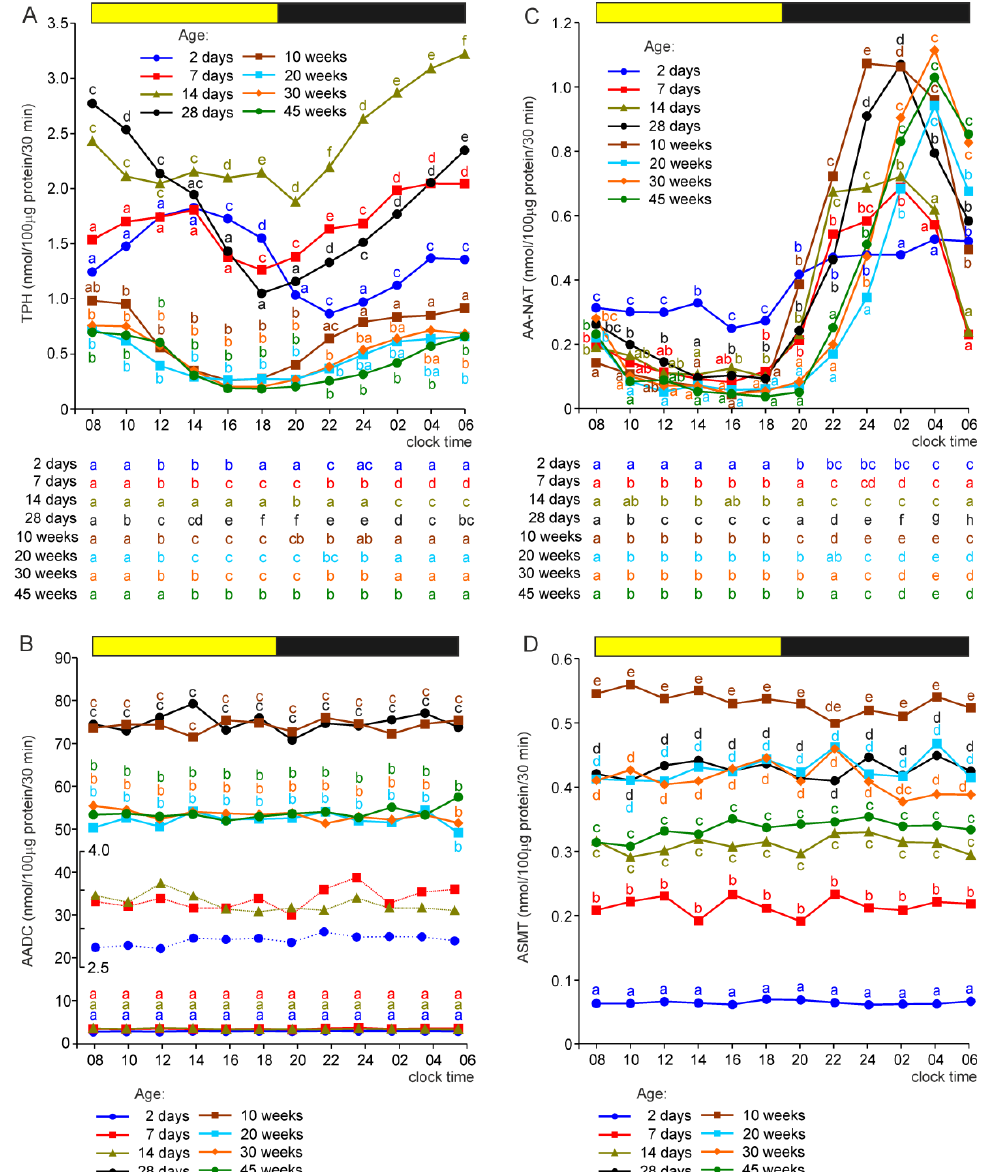
Figure 1. Activity (means) of tryptophan hydroxylase, TPH ( A ), aromatic amino acid decarboxylase, AADC ( B ), arylalkylamine N-acetyltransferase, AA-NAT ( C ), and N-acetylserotonin O-methyltransferase, ASMT ( D ) in the pineal organs of turkeys at the ages of 2, 7, 14, 28 days and 10, 20, 30, 45 weeks. The horizontal bar represents the periods of light and dark phases of the daily cycle. The letters on the charts show differences between age groups at each time-point in Duncan’s test. The letters below the charts show differences between time-points within a group in Duncan’s test. The same letters indicate means which are not significantly different. Insert in figure ( B ) shows AADC activity in the pineal organs of turkeys aged 2, 7, and 14 days at the limited y -axis scale.